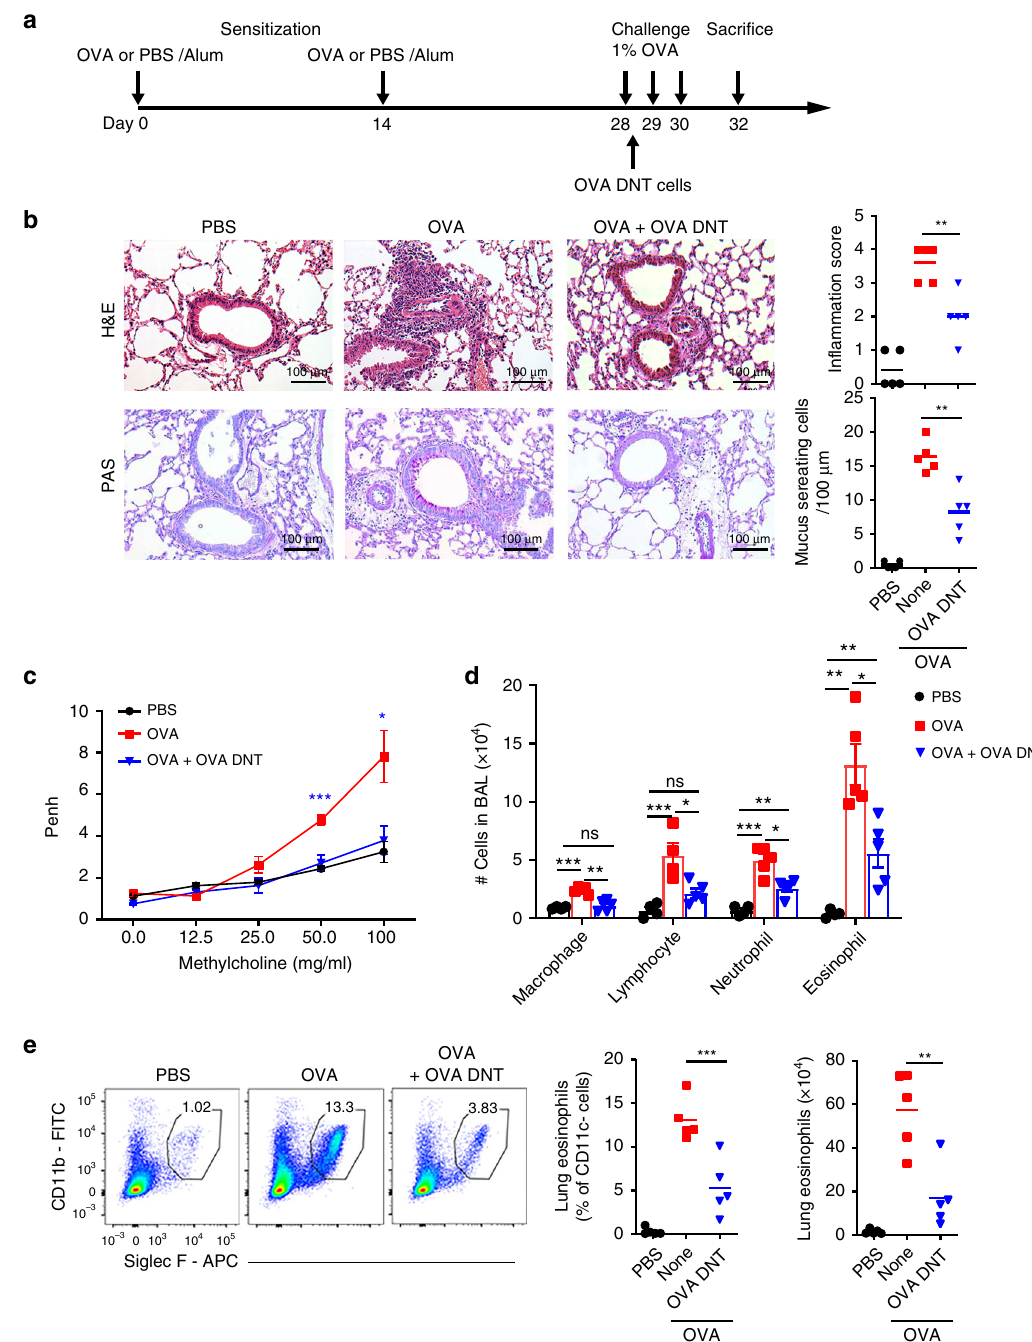
Fig. 1 OVA DNTs suppressed OVA-induced airway in fl ammation. a Schematic representation of the experimental procedure. Mice were sensitized with two intraperitoneal injections of ovalbumin (OVA) or PBS in an alum adjuvant at days 0 and 14. The mice received 2 × 10 6 OVA-primed DNT cells (OVA DNTs) by intravenous adoptive transfer after the fi rst 1% OVA aerosol challenge on day 28. The mice were challenged daily for the next two days and sacri fi ced 48 h after the last aerosol challenge. b Lung sections were stained with H&E and PAS to measure the numbers of in fi ltrated in fl ammatory cells and mucus-secreting cells. (Scale bars, 100 µ m). c The airway hyperreactivity index and the Penh values were investigated 24 h after the last challenge. d After the mice were sacri fi ced, the bronchoalveolar lavage (BAL) fl uid was collected and stained with Diff-Quik stain. Cells from the BAL fl uid were counted and classi fi ed as macrophages, lymphocytes, neutrophils or eosinophils. e The percentage and numbers of eosinophils (Siglec F + CD11b + CD11c - ) in the lung were assessed by fl ow cytometry. The results are representative of 4 – 5 experiments with similar results. Data are shown as the mean ± SEM; n = 5 mice per group. One-way ANOVA was used to calculate signi fi cance. * P < 0.05; ** P < 0.01; *** P < 0.001. The source data are provided as a